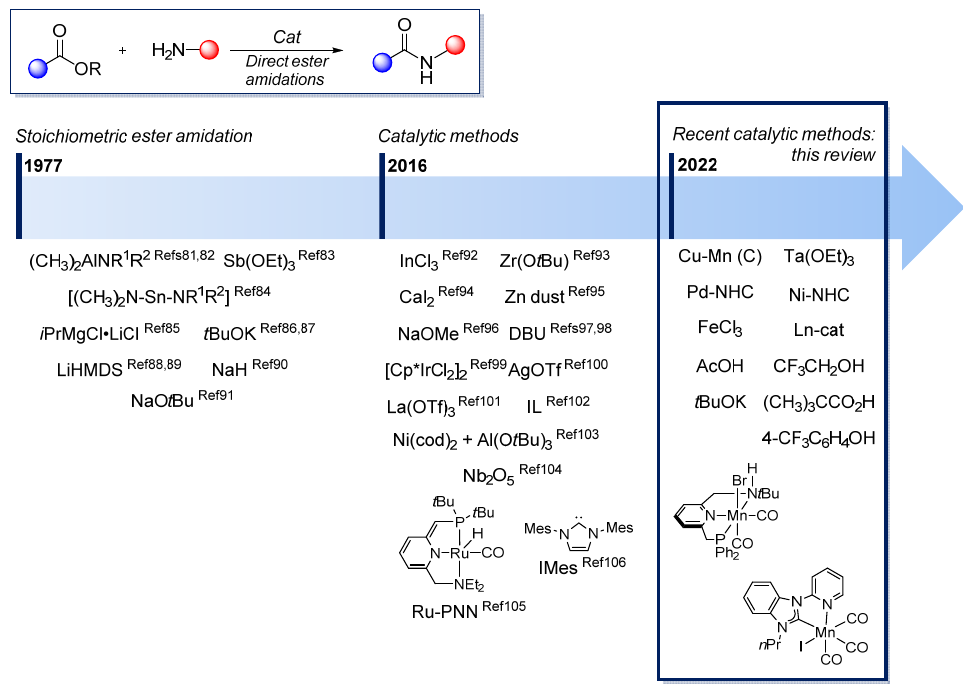
Figure 6. Direct ester amidations: overview of main methods since 1977 [81–106].